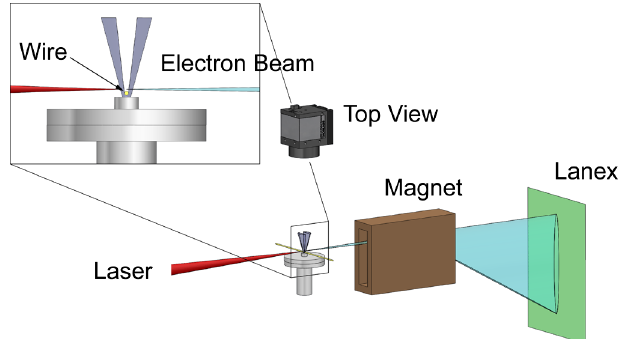
FIG. 1. Experimental setup: The laser pulse enters from the left and impinges on the gas jet 0.7 mm above the nozzle. The wire is positioned (cid:1) 0 : 2 mm above the orifice. Top view and a permanent magnet Lanex electron spectrometer serve as primary diagnostics. The position z ¼ 0 along the laser axis is centered above the